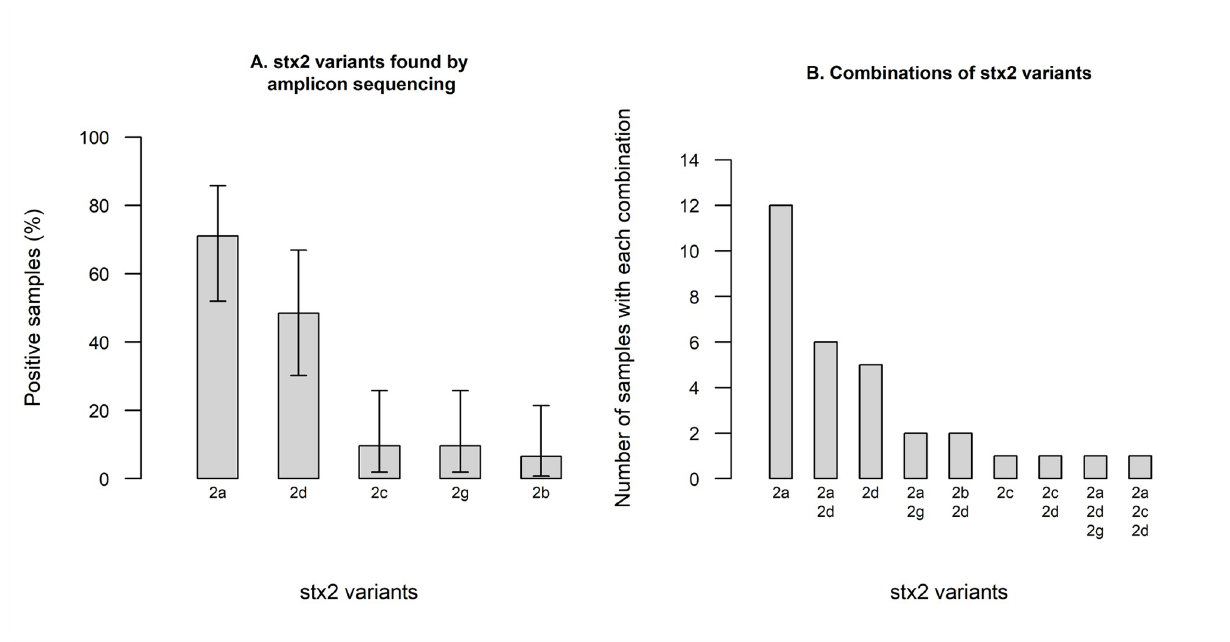
Fig 1. Prevalence of Shiga toxin 2 variants in 31 stx 2 -positive skin samples from Swedish cattle evaluated by amplicon sequencing. The figure shows (A) the prevalence, with 95% confidence intervals, of each stx 2 variant and (B) combinations of different toxin variants found in individual samples.